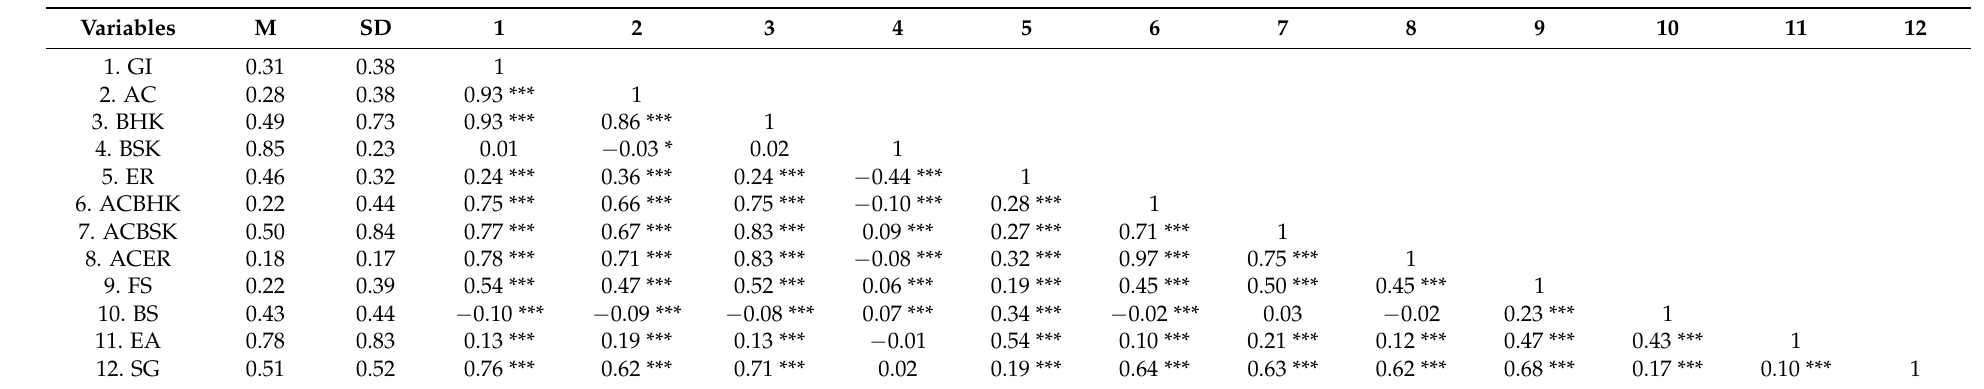
Table 1. Correlation Test and Descriptive Stats.